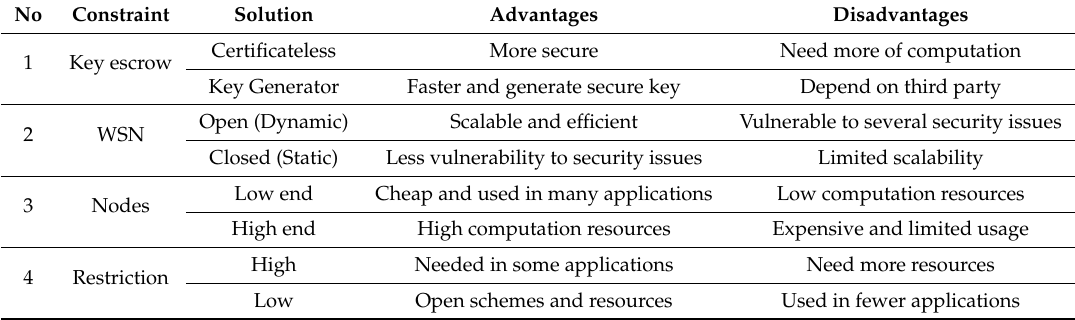
Table 1. General constraints for encryption in